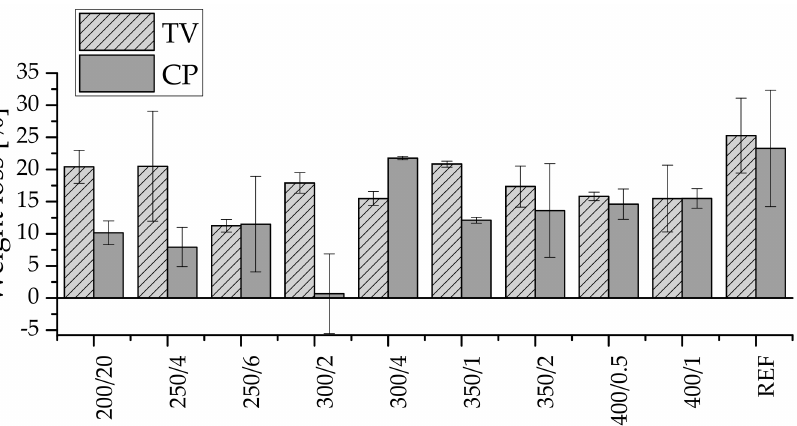
Figure 5. Weight loss of wood attacked by Coniophora puteana (CP) and Trametes versicolor